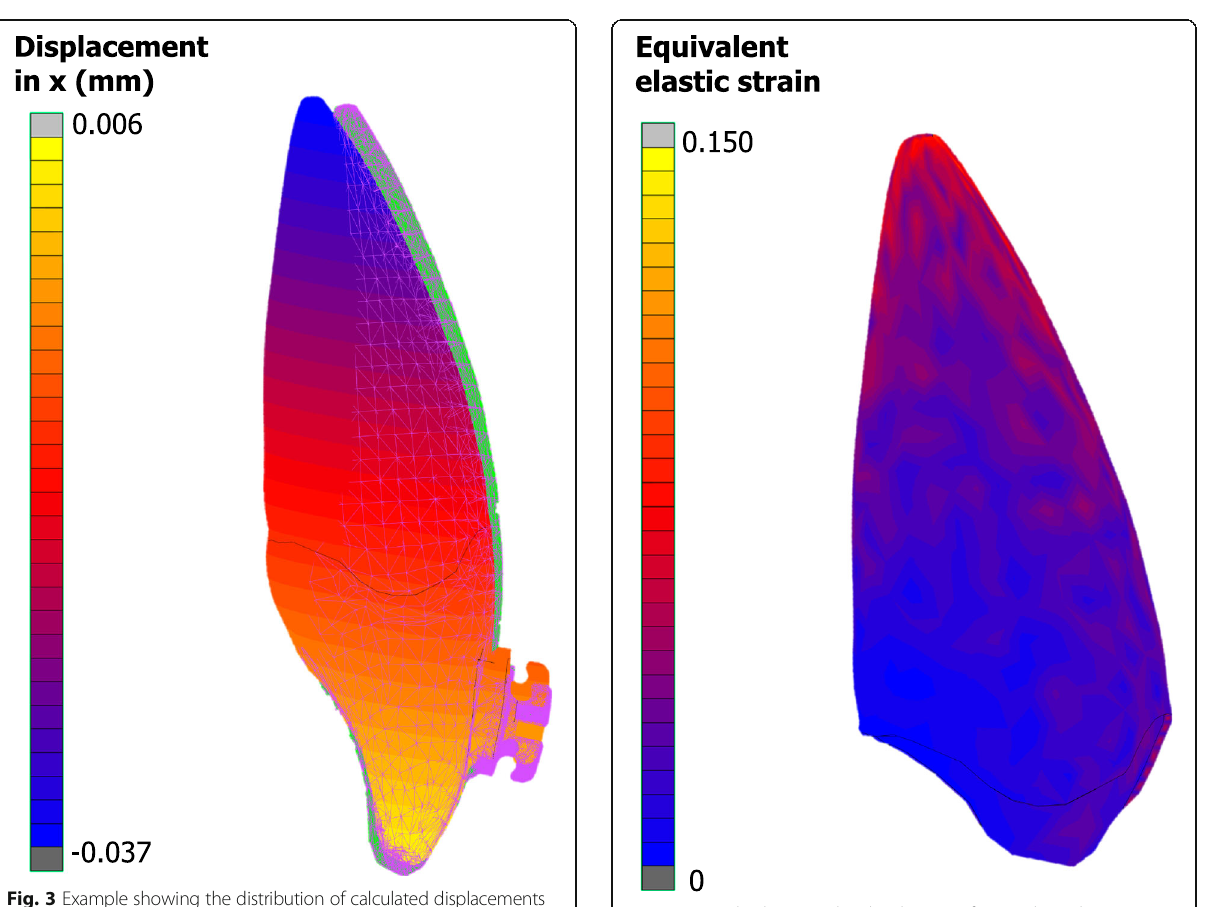
Fig. 4 Example showing the distribution of equivalent elastic strain in the periodontal